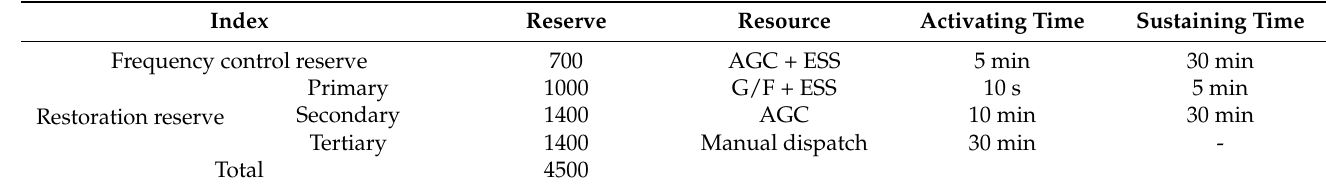
Table 1. Reserve criteria for frequency ancillary service in the Korean power system, Adapted from Ref. [33].